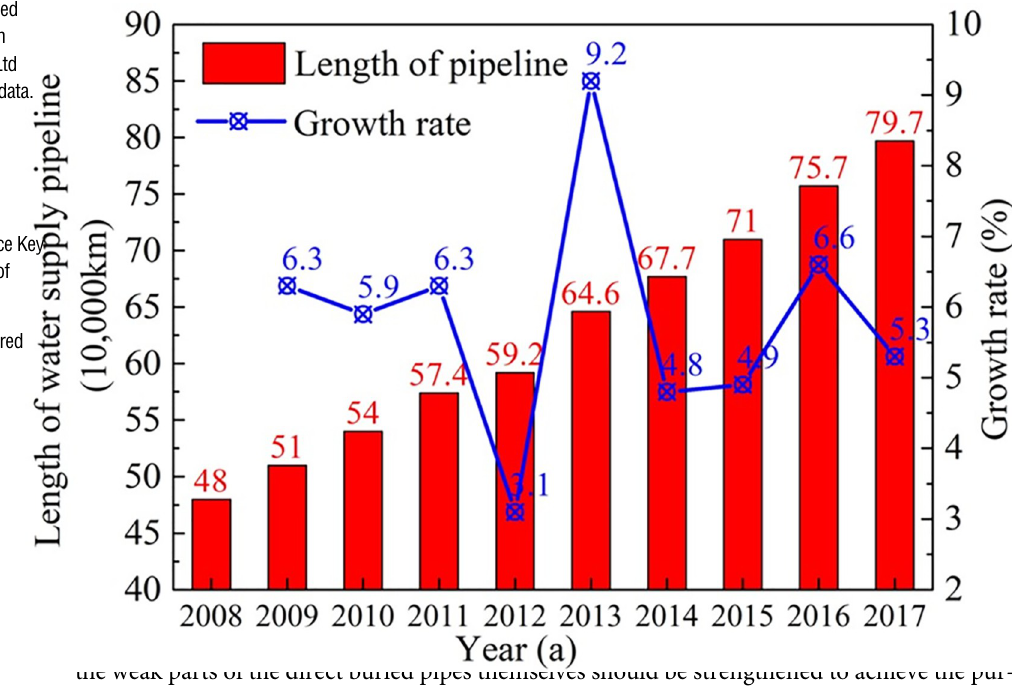
Fig 1. Current status of water supply pipeline length in